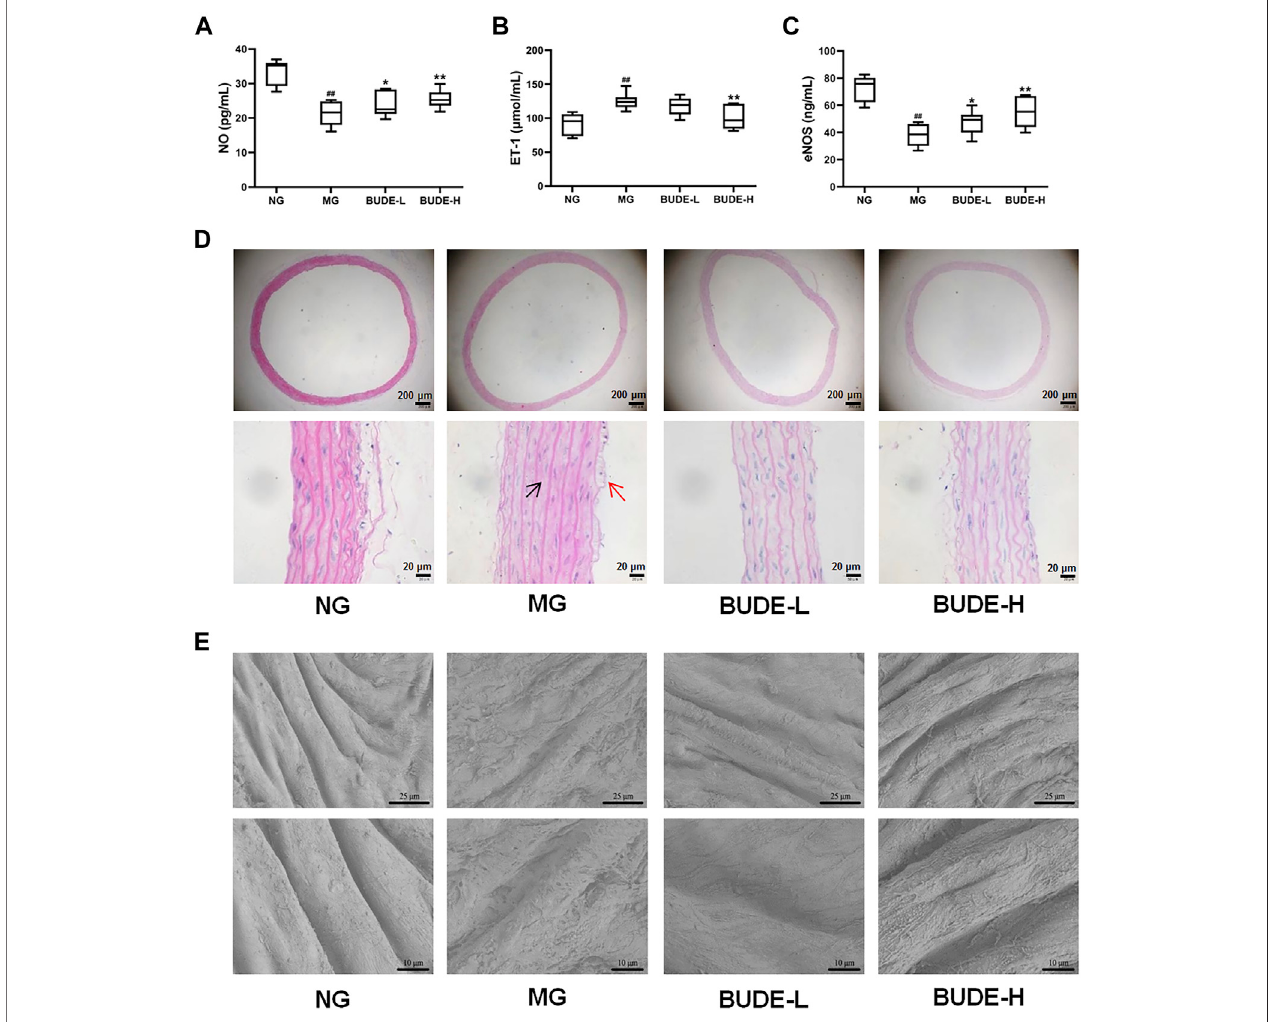
FIGURE4| Effect ofBUDE onvascularendothelial. (A) Changesinthe plasmanitric oxide(NO). (B) Changesinthe plasmaendothelin1 (ET-1). (C) Changesin the plasma endothelial nitric oxide synthase (eNOS). (D) Representative graph ( × 40, × 400) of H&E staining of the vessels: shedding of endothelial cells (red arrow) and smooth muscle cell hypertrophy (black arrow). (E) Vessel ultrastructure by scanning electron microscopy (SEM) observed at magni fi cation 1,000 × and 2000 × . Compared with the normal control group # p < 0.05, ## p < 0.01; compared with the model control group * p < 0.05, ** p < 0.01, n (cid:2) 9.